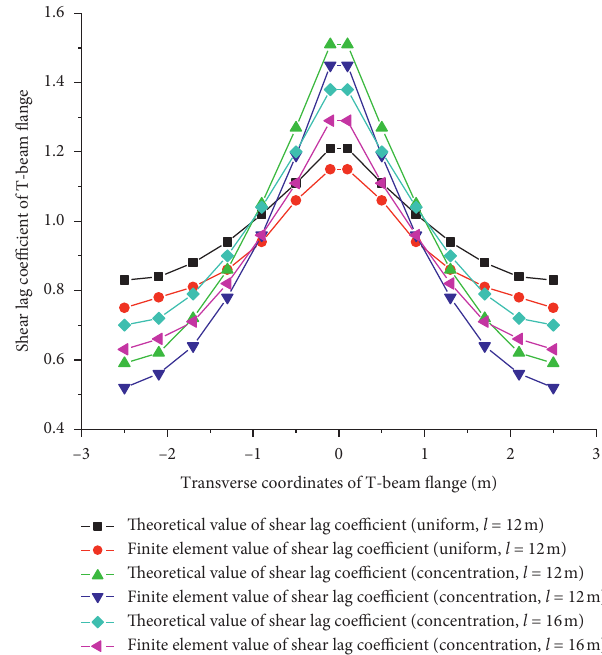
Figure 5: Shear lag coefficients for simply supported T-beams. Table 3: Stress on webs for simply supported T-beams ( L Vertical coordinates of web (m)